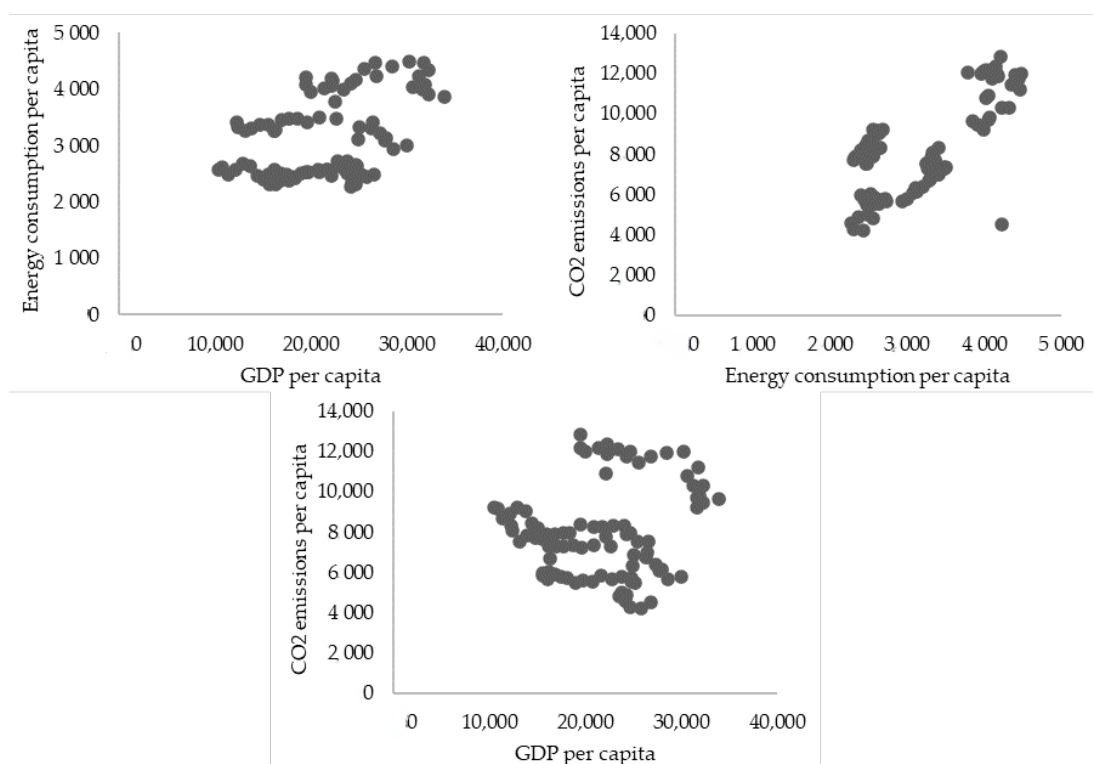
Figure 5. Relationships of the studied features in V4 countries in 1992 – 2015.